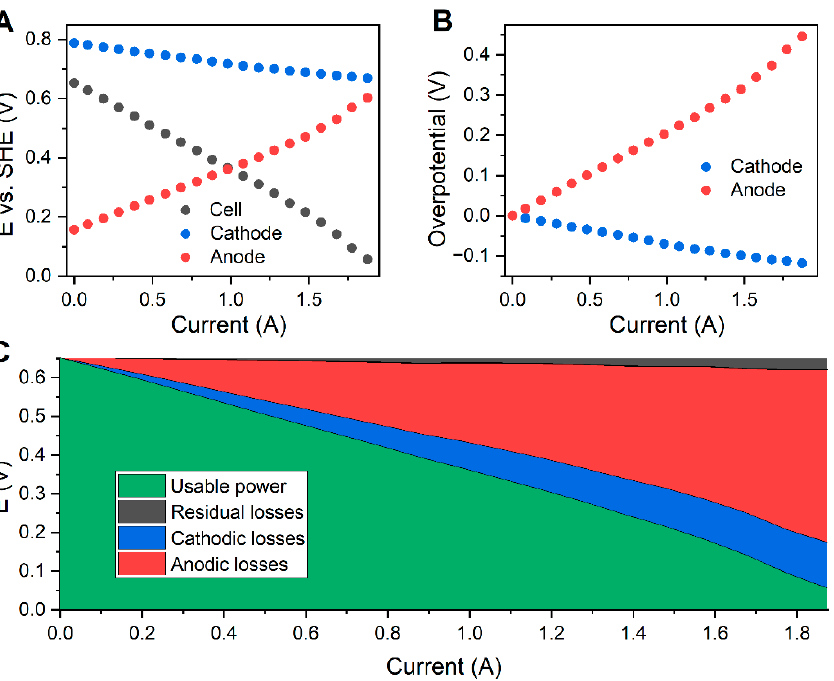
Figure 5. ( A ) Cell voltage, positive and negative electrode potentials ( B ) Electrode overpotentials ( C ) Polarization curves with separated losses. ABRFB using ASM as negolyte, flow field—flow through, flow rate—100 mL min − 1 , SOC 100%. Electrode—carbon felt Sigracell GFD 4.6.